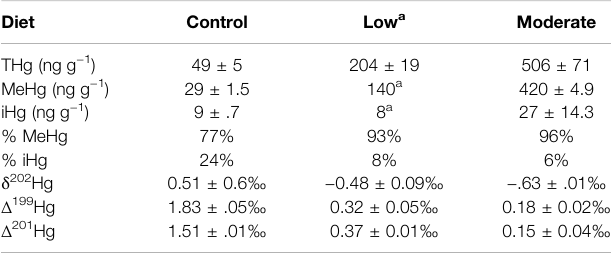
TABLE 1 | THg, MeHg, and iHg concentrations (as ng g − 1 dw), percentages of MeHgandiHg(as%),andHgisotopiccomposition(as ‰ )ofdietarypelletsfor the different exposure